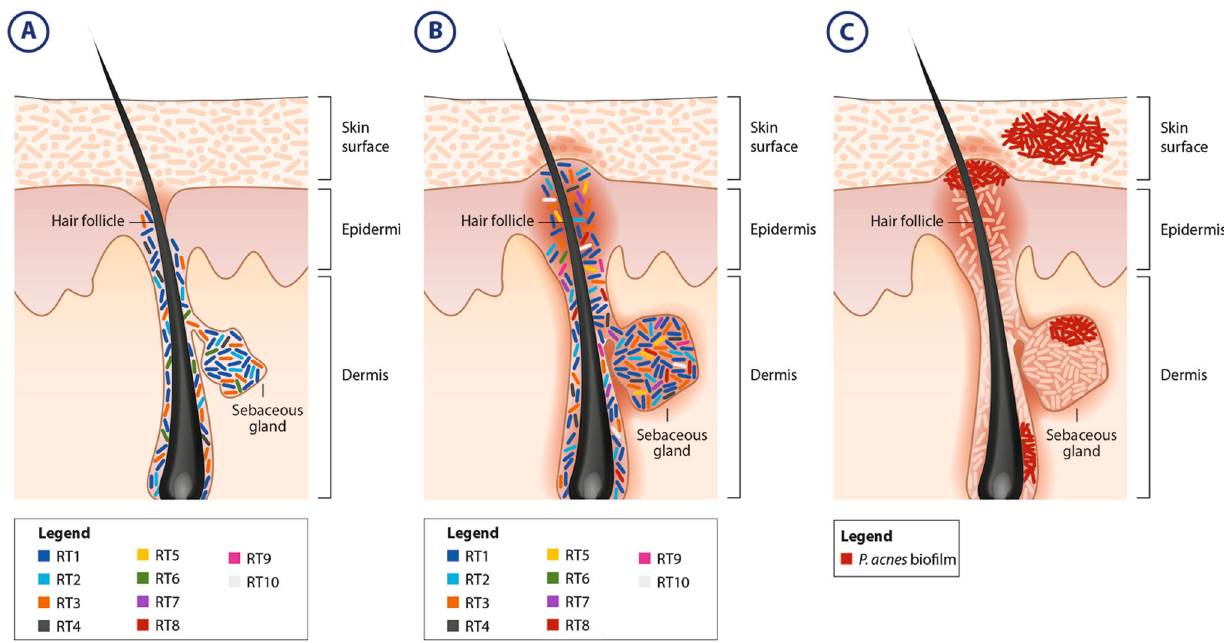
Fig. 2. Relative P. acnes strain abundance in the nose pilosebaceous unit is different between acne patients and healthy individuals. a Normal relative abundance of dominant P. acnes strains in healthy individuals. b Acne-induced dysbiosis is characterized by a decrease in the relative abundance of P. acnes strains RT3 and RT6, and an increase in the relative abundance of strains RT4, RT5, RT7, RT8, RT9, and RT10. 53 c The persistent nature of acne vulgaris and its ability to be only partially ameliorated through antibiotics can be due to pockets of bio fi lm-forming P. acnes strains located on various skin appendages, including on the skin surface, the sebaceous gland, the hair follicle, and the pore